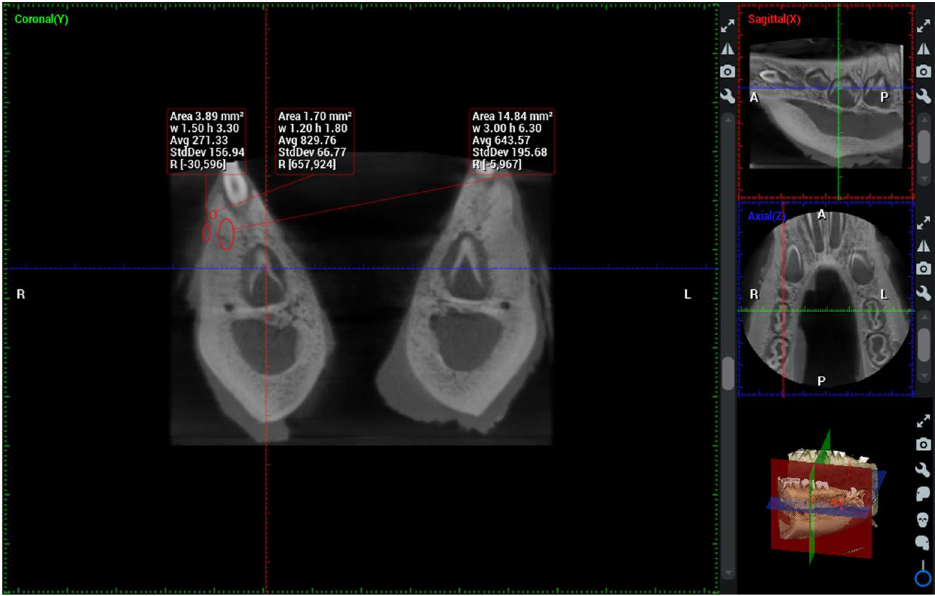
Figure 9. Analysis of bone density with CBCT and regions of interest